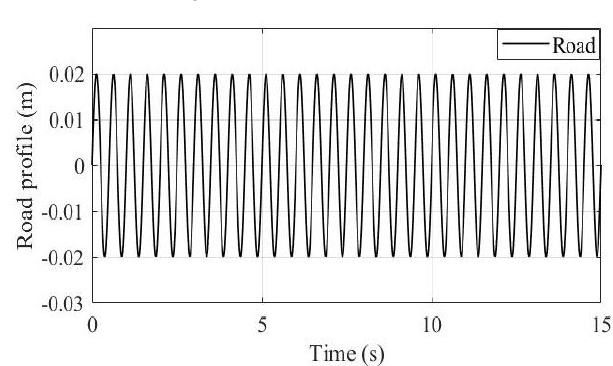
Figure 8. Control signal (V).